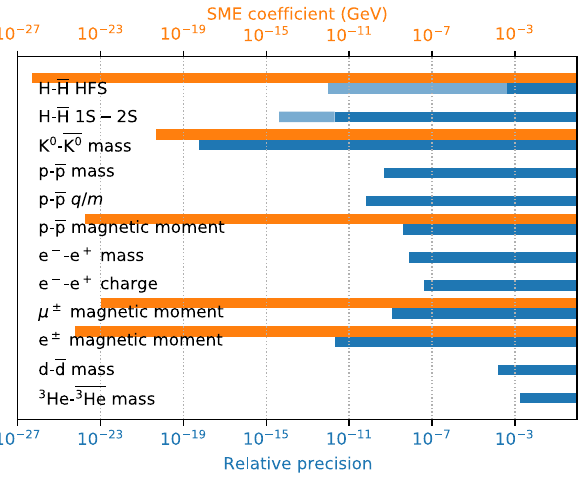
Fig. 6 Summary of recent bounds on the direct CPT tests [388]. Blue lines represent relative experimental precision and the corresponding SME coefficients for various quantities, while orange one show the existing experimental values. Although it is not straightforward to map neutrino (cid:8) m 2 − (cid:8) ¯ m 2 limits here, it is order 7 higher precision than equivalent m 2 ( e − ) − m 2 ( e + ) from this